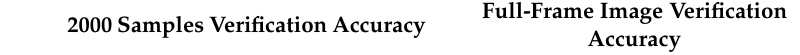
Table 2. Accuracy of 2000 verification samples. Statistical results of full-frame image verification accuracy (total 323,600